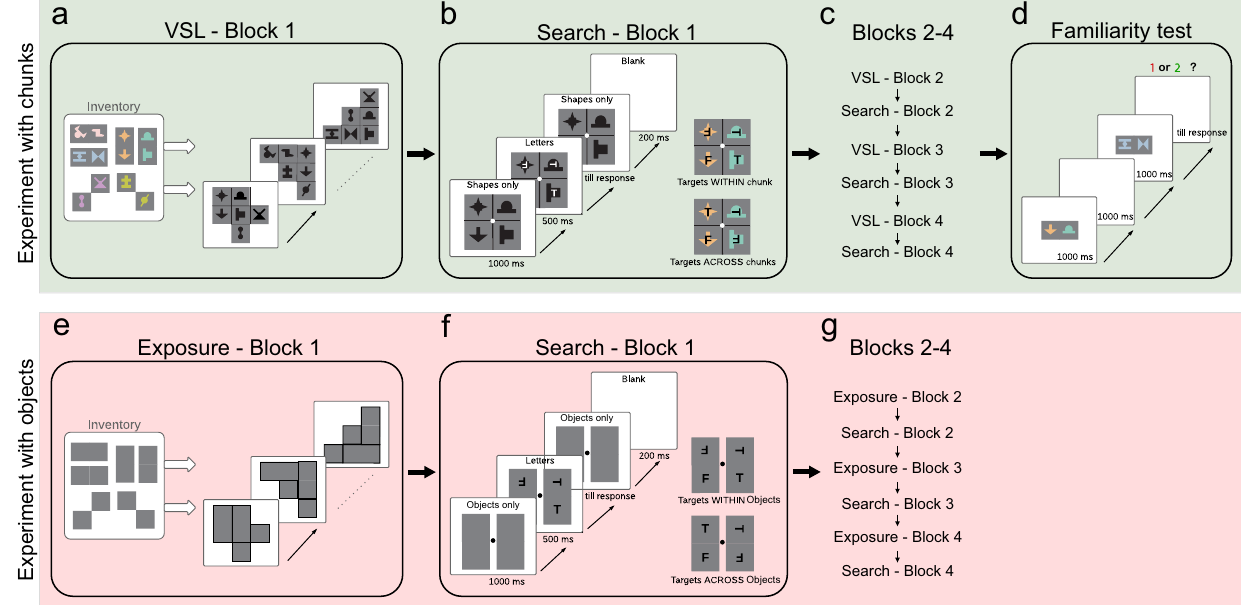
Fig. 1 The stimuli, the tasks, and the design of Experiment 1. a – d The design of Experiments 1a and 1b using statistical chunks de fi ned by co-associated abstract shapes. In the Exposure blocks ( a VSL - Block 1), true-pairs (Inventory) were used to generate 144 complex scenes for passive viewing. In the Search blocks ( b Search - Block 1), observers performed a letter search task with white letters superimposed on the shapes, where the two target letters could be within or across pairs ( b inset, using black letters for visibility). Exposure and Search blocks were presented in an alternating manner ( c Blocks 2 – 4). After the last Search block, a standard VSL Familiarity test was administered to measure the observer ’ s bias to true chunks over random combinations of elements ( c Familiarity test). Coloring of the shapes in this fi gure is only for demonstration purposes, all shapes in the displays were shown in black with no indication of chunk identity. e – g The design of Experiment 1c using objects de fi ned by visual boundary cues. In the Exposure blocks ( e Exposure - Block 1), rectangles and squares were used that corresponded to the silhouettes of the pairs in Experiments 1a and 1b. In the Search blocks ( f Search - Block 1), observers performed a letter search task with letters appearing in separated rectangles and squares. f (insets) Trials within (top) and across (bottom) object setups of targets. The block design of Exp 1c followed that of Experiments 1a and b ( g Blocks 2 – 4). The shapes and the letters are magni fi ed in the fi gure compared to the actual experimental